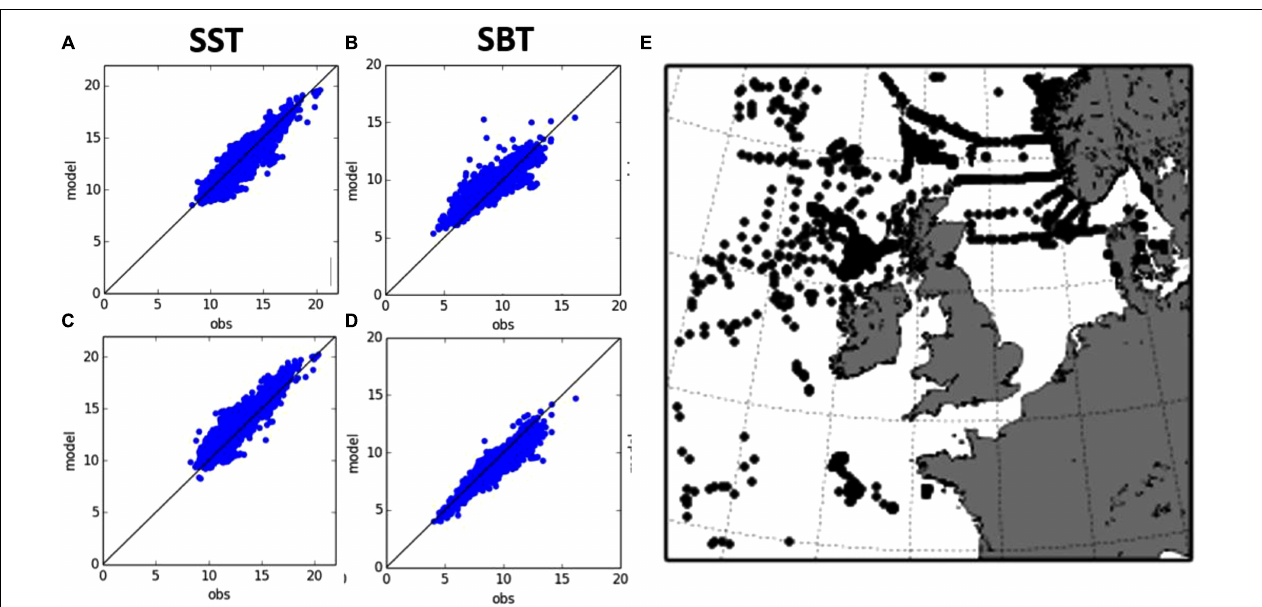
FIGURE 1 | Observed vs. modeled sea surface (A) and sea bottom temperature (B) from profile observations for the current configuration of the Met Office AMM15 shelf seas forecasting system and with proposed changes to the vertical mixing and light attenuation schemes (C,D) . Also shown (E) is a map of the location of all temperature profiles for spring 2014 available from